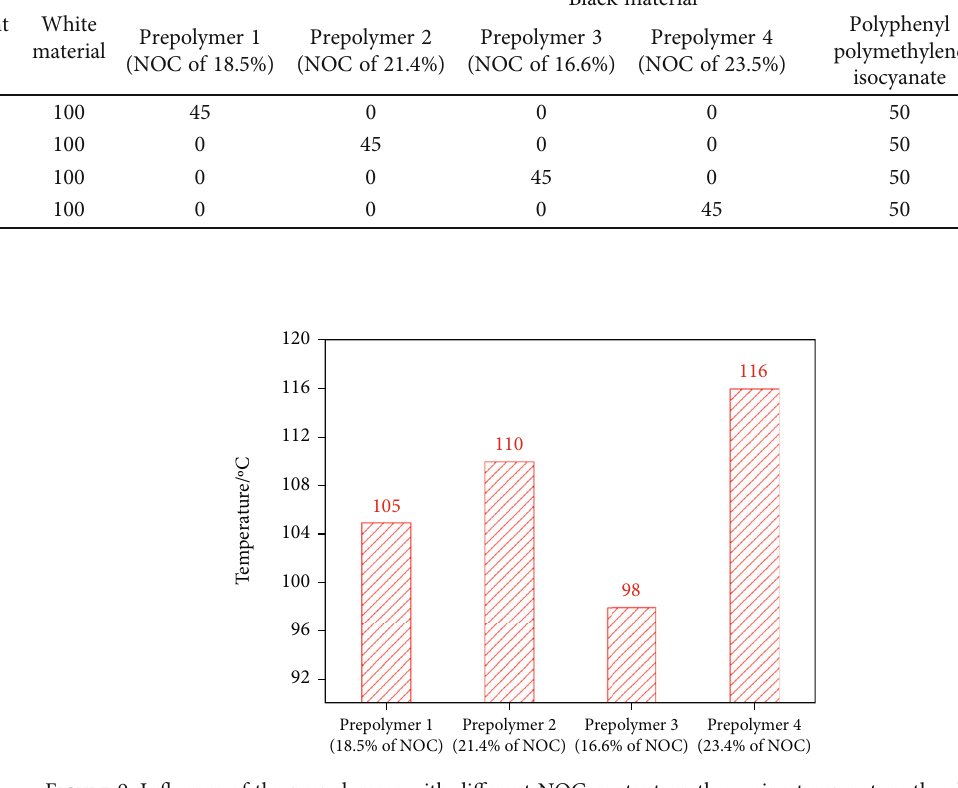
Figure 9: In fl uence of the prepolymers with di ff erent NOC content on the curing temperature